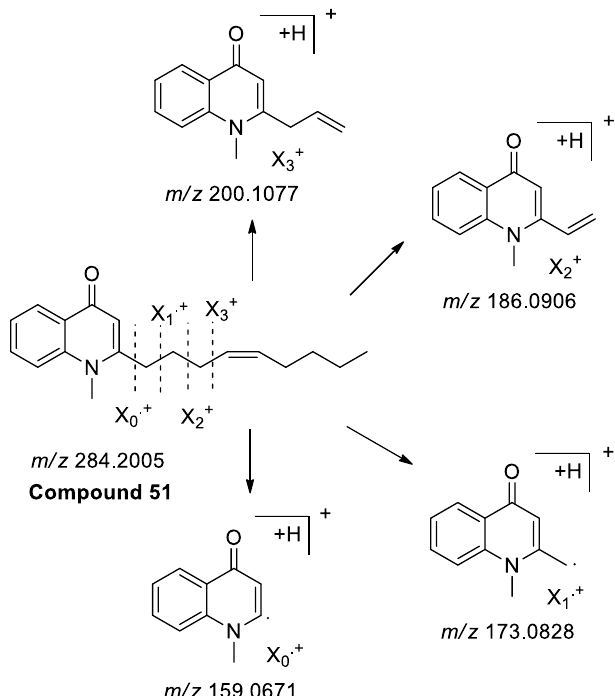
Figure 3. MS/MS proposed fragmentation pathways of 1-methyl-2-[( Z )-4-nonenyl]-4(1 H )-quinolone. Figure 3. MS / MS proposed fragmentation pathways of 1-methyl-2-[( Z )-4-nonenyl]-4(1 H